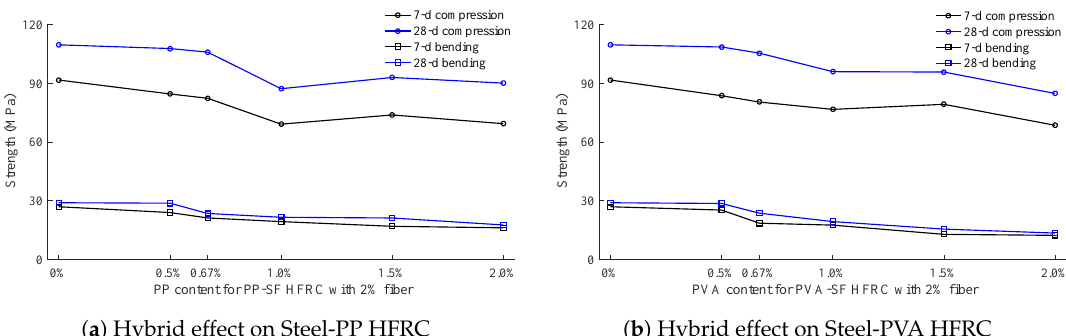
Figure 3. Hybrid effect on compressive and flexural strength.